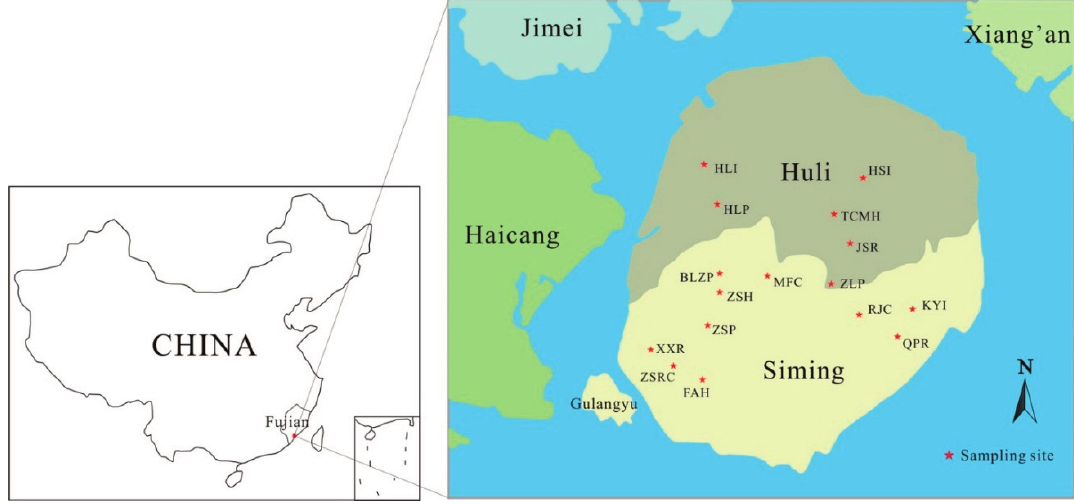
Figure 1. Map of Xiamen City and sampling sites ( Parks : Zhongshan Park (ZSP), Bailuzhou Park (BLZP), Zhonglun Park (ZLP), and Huli Park (HLP); Hospitals : First Affiliated Hospital of Xiamen University (FAH), Zhongshan Hospital of Xiamen University (ZSH), and Xiamen Hospital of Traditional Chinese Medicine (TCMH); Commercial areas : Zhongshan Road commercial area (ZSRC), Ruijing commercial area (RJC), and Mingfa commercial area (MFC); Industrial areas : Kaiyuan industrial area (KYI), Huli industrial area (HLI), and Heshan industrial area (HSI); and Residential areas : Xiaxi residential area (XXR), Qianpunan residential area (QPR), and Jinshang residential area (JSR)). Table 1. Description of the sampling sites and meteorological conditions. Sampling